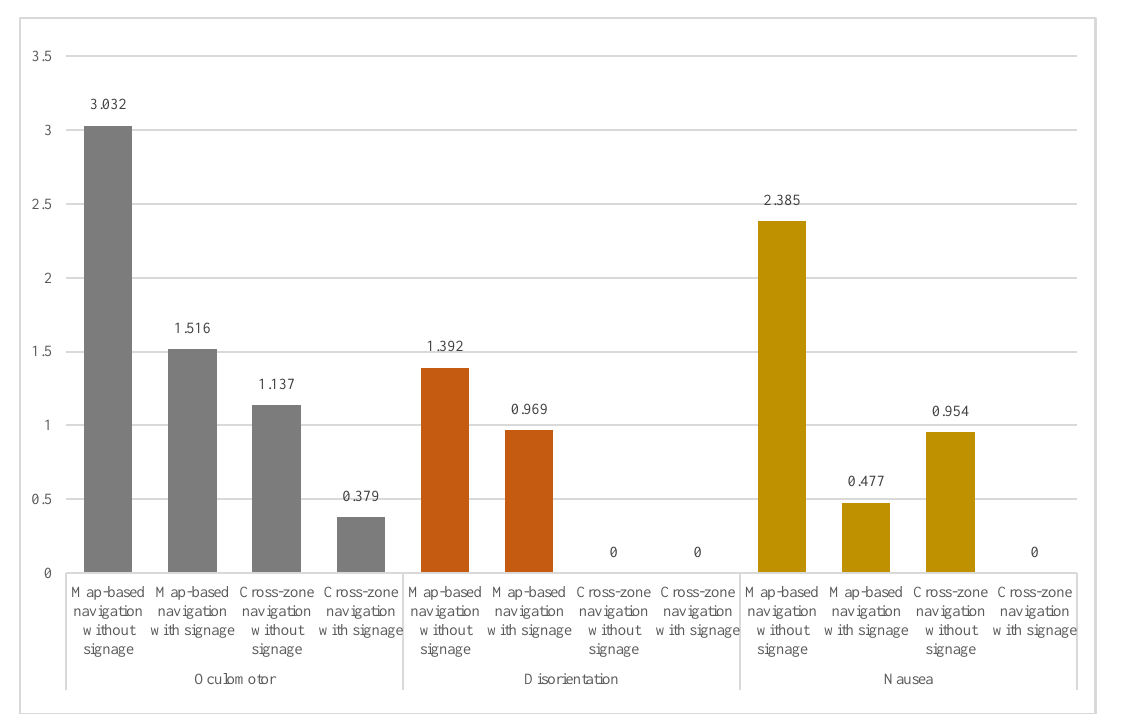
Figure 12. The average SSQ subscores of different system combinations on three distinct symptom clusters (oculomotor, disorientation, and nausea).